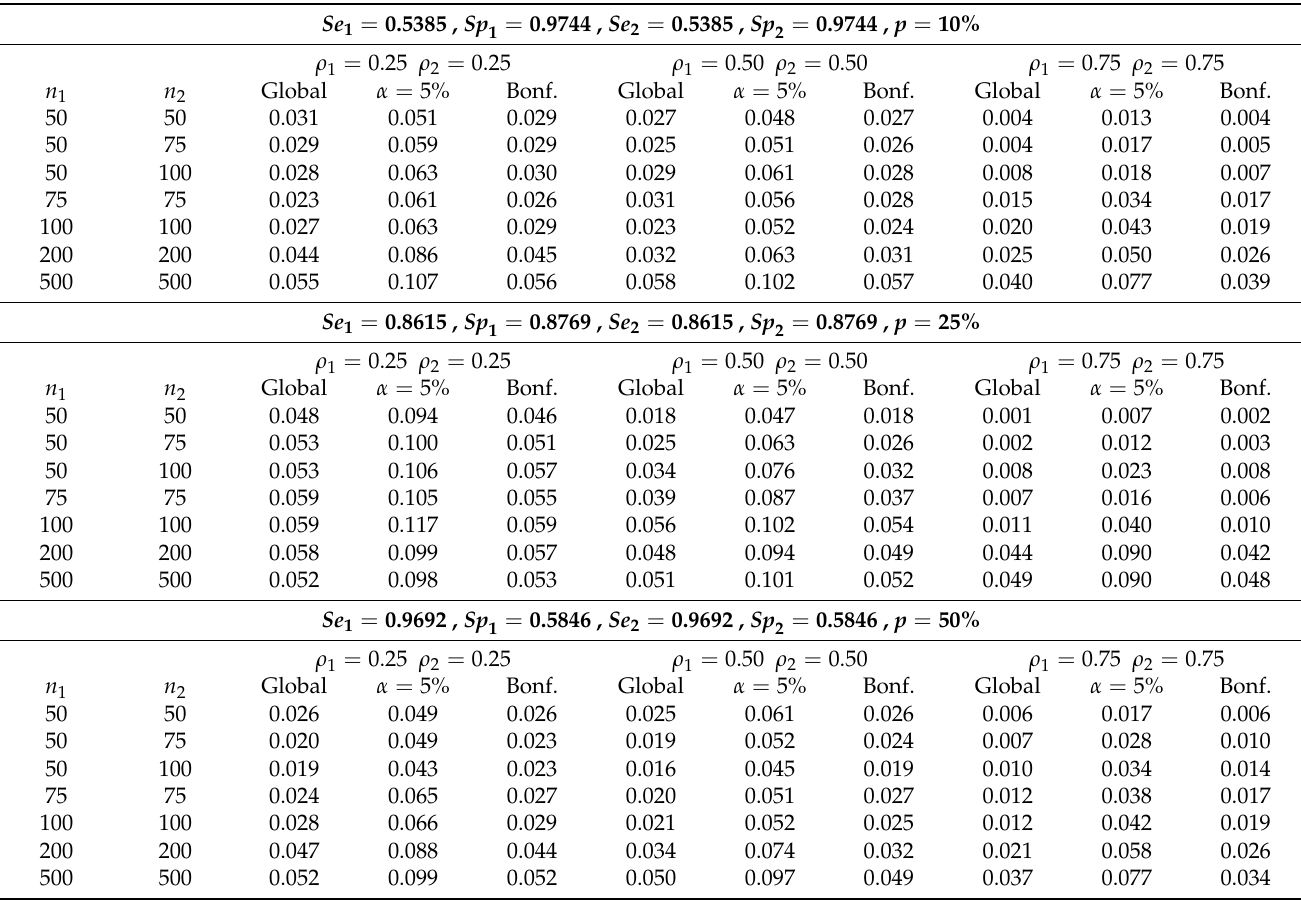
Table 2. Type I errors for PPV 1 = PPV 2 = 0.70 and NPV 1 = NPV 2 =